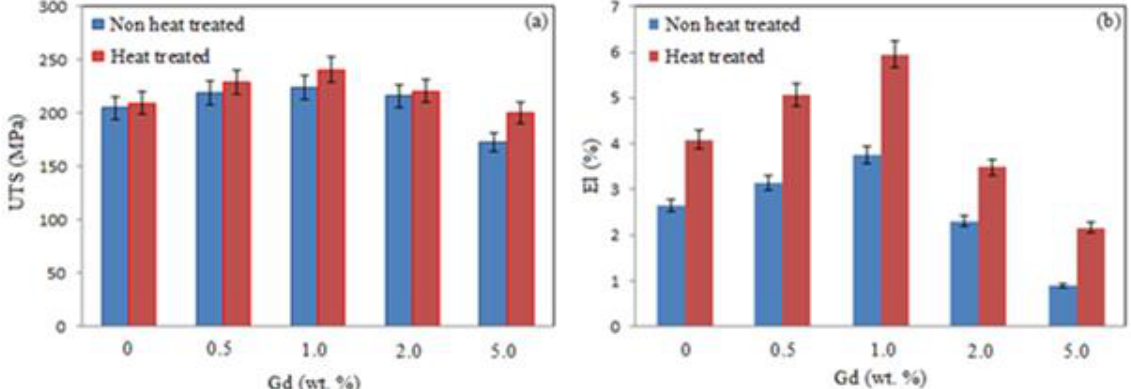
Fig. 4. The UTS (a) and elongation percentage (b) values of Al–15%Mg 2 Si composite as a result of heat treatment, with respect to Gd concentration